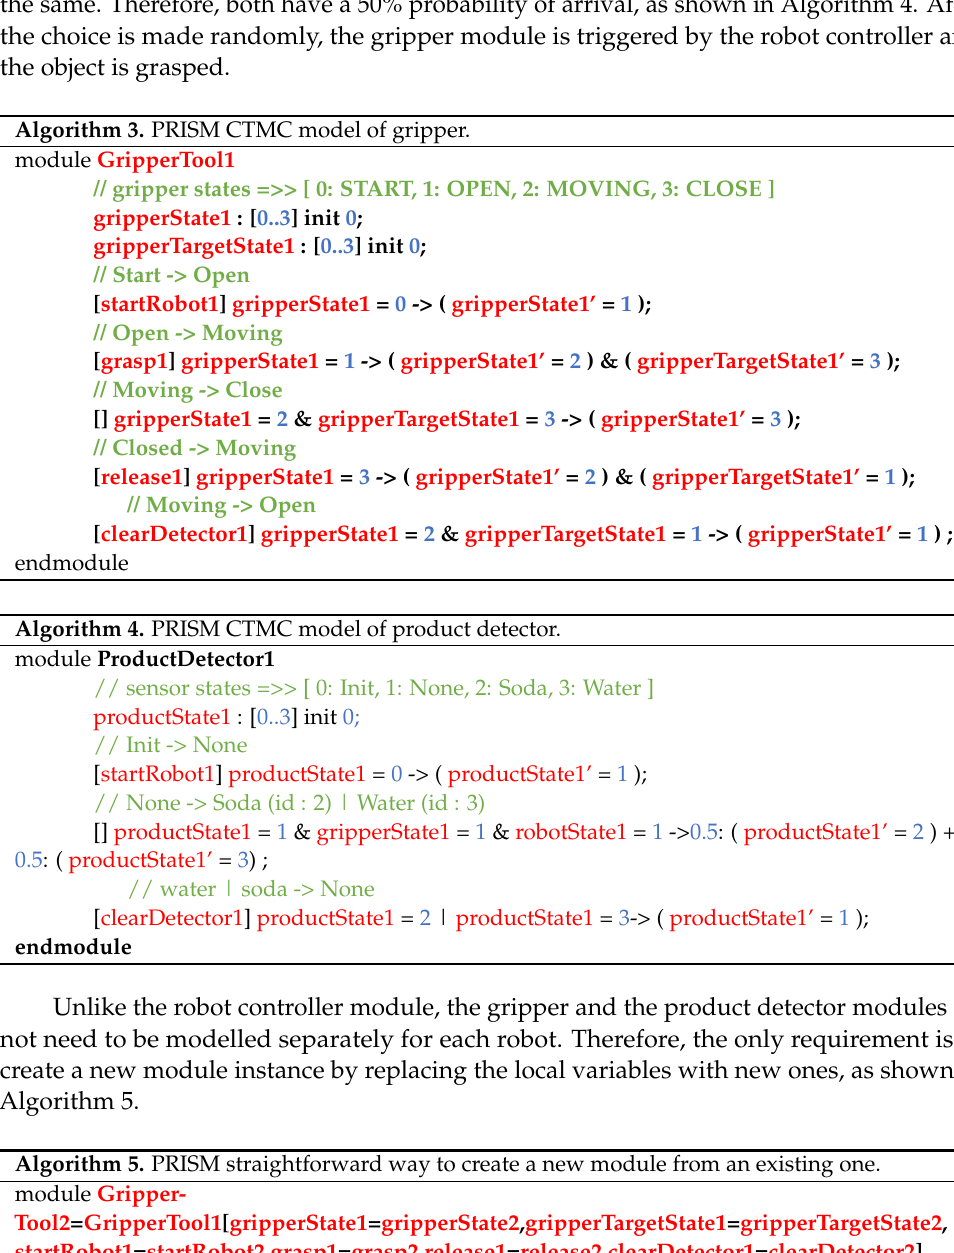
Algorithm 5. PRISM straightforward way to create a new module from an existing